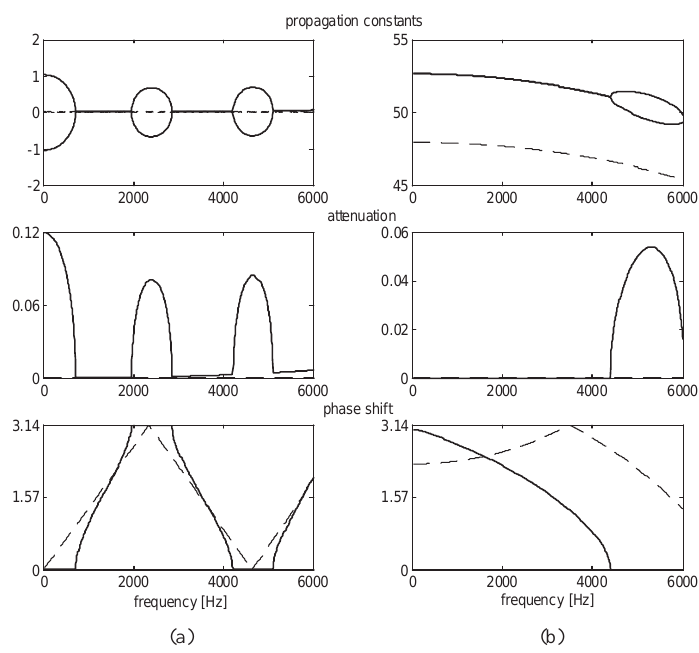
Fig. 5. Propagation constants of uniform (dash) and linear-tapered (solid) shell: (a) longitudinal direction, (b) radial direction.